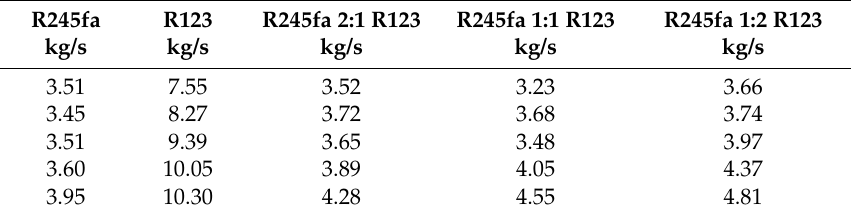
Table 4. The mass flow rates of hot oil.